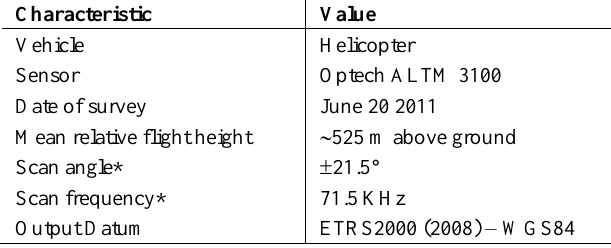
Table 1. Characteristics of the survey flight.